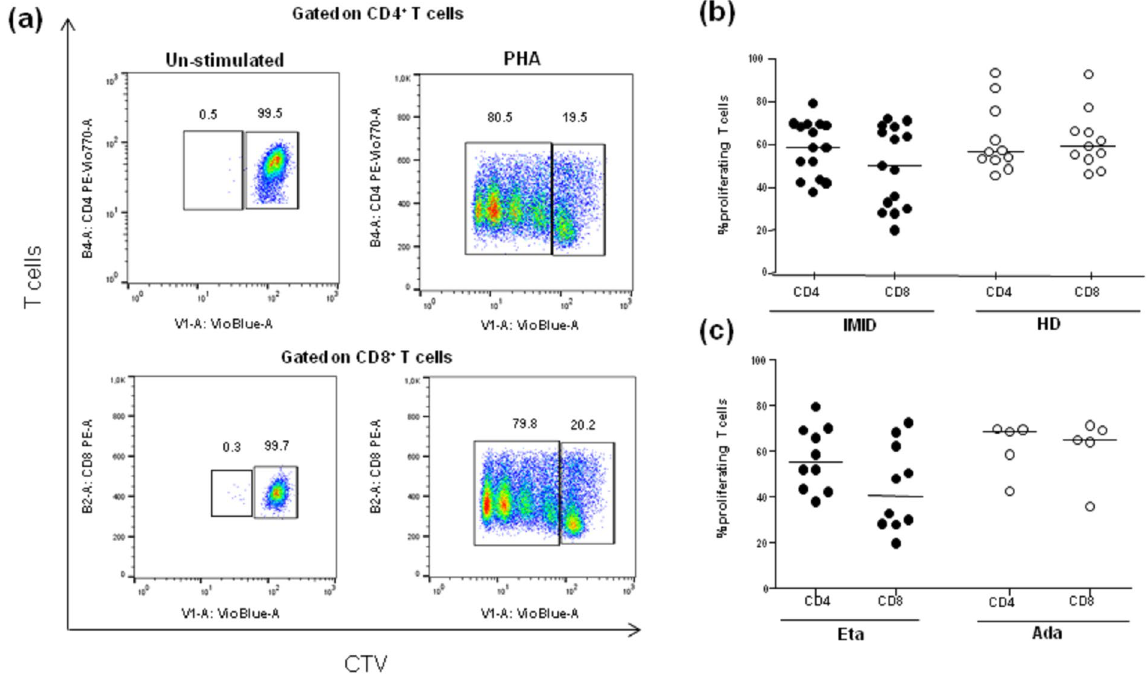
Figure 3. Ex vivo proliferation assay of CD4 + and CD8 + T cells. ( a ) Representative proliferation dot plots of CD4 + and CD8 + T cells in healthy donors (HD). The proliferation was assessed staining PBMCs with the fluorescent dye Cell Trace Violet (CTV) and determining the CTV content of CD4 + and CD8 + T cells after 5 days of stimulation with medium alone ( left ) or phytohemagglutinin (PHA) at 5 μ g ( right ). In response to PHA, the figure depicts CD4 + and CD8 + T cells that have divided 3–4 times based on CTV dilution intensity; in contrast, in medium alone, the T cells did not show any divisions. (b) Cumulative analyses of the frequency of CD4 + and CD8 + T cells endowed with the proliferation ability in response to PHA in IMID patients (n = 15) and HD subjects (n = 11). Statistical analysis was performed using the Mann-Whitney test to compare IMID and HD subjects and significant p -values are indicated. (c) Frequencies of proliferating T cells were assessed according to the type of biological agent. Statistical analysis was performed using the Mann-Whitney test to compare subjects treated with Eta and Ada. The proliferation of T cells was expressed as the percentage of CD4 + and CD8 + T cells in CTV low gate. Horizontal bars represent the median